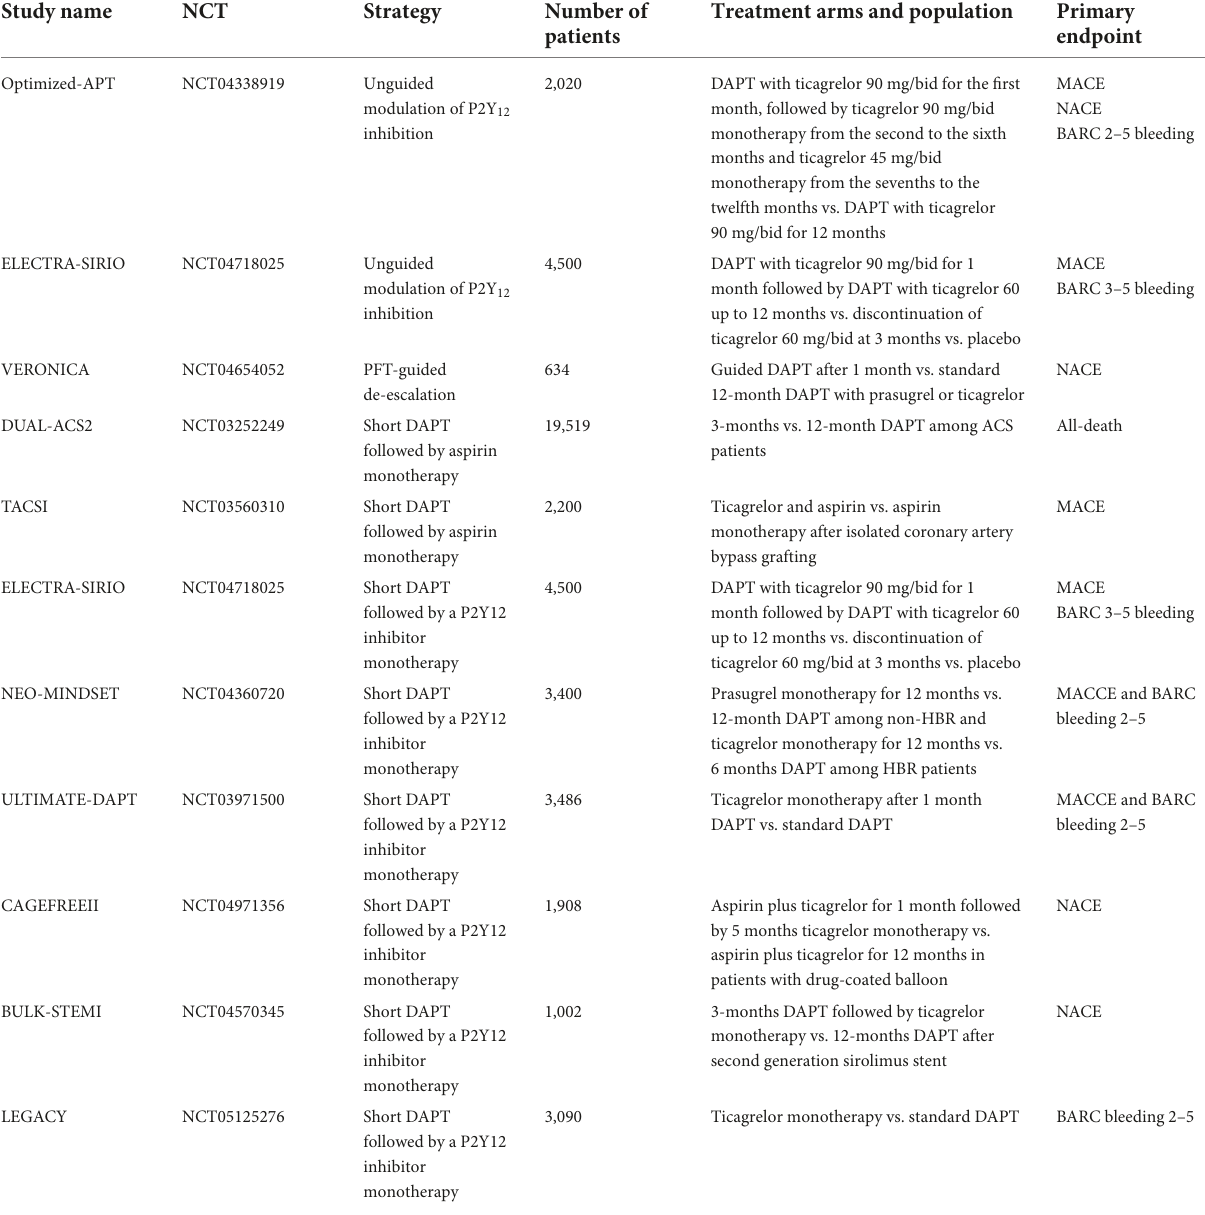
TABLE 2 Ongoing studies on de-escalation strategies in acute coronary